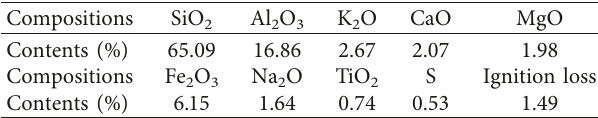
Table 1: Analysis results of main chemical components of coal